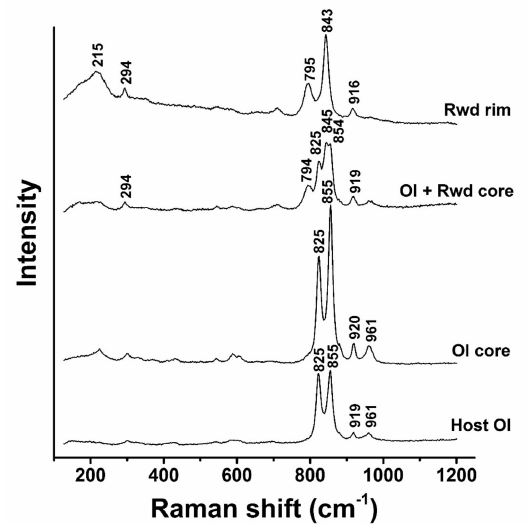
Figure 4. Raman spectra of olivine and ringwoodite in the GRV053584. Host Ol—the host olivine clast in the chondritic portion, Ol core and Ol + Rwd core—the central region of the olivine-ringwoodite clast, Rwd rim—the rim region of the olivine-ringwoodite